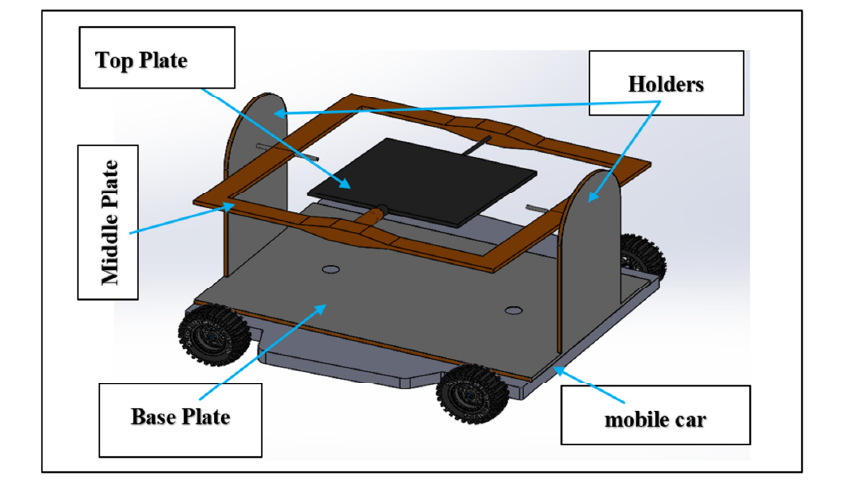
Fig. 7. The CAD drawing for the proposed prototype of the 3D self-balancing platform on mobile